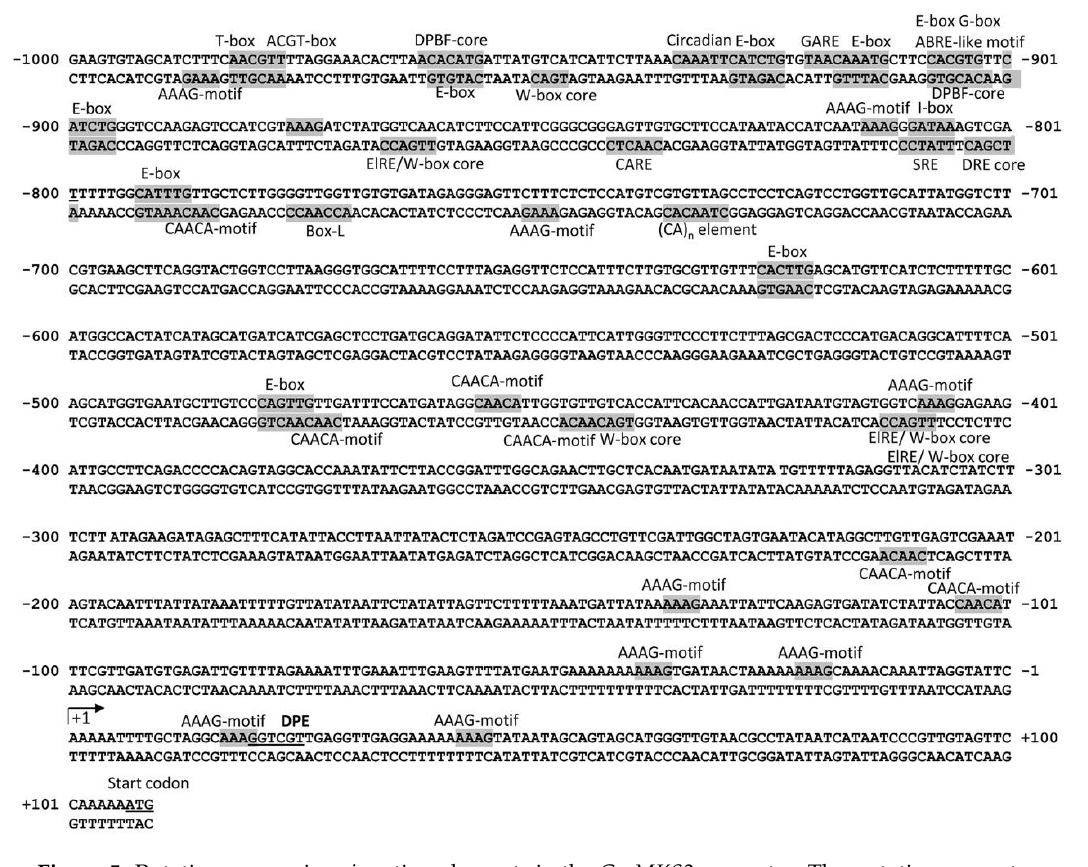
Figure 5. Putative responsive cis -acting elements in the GmMKS2 promoter. The putative promoter region spanning from − 1000 to + 101 relative to the GmMKS2 transcription start site was amplified from G. max genomic DNA, sequenced, and scanned through PLACE for the identification of number and position of various cis -acting regulatory elements. Sequences corresponding to putative regulatory elements are shaded. The arrow indicates the transcription start site.